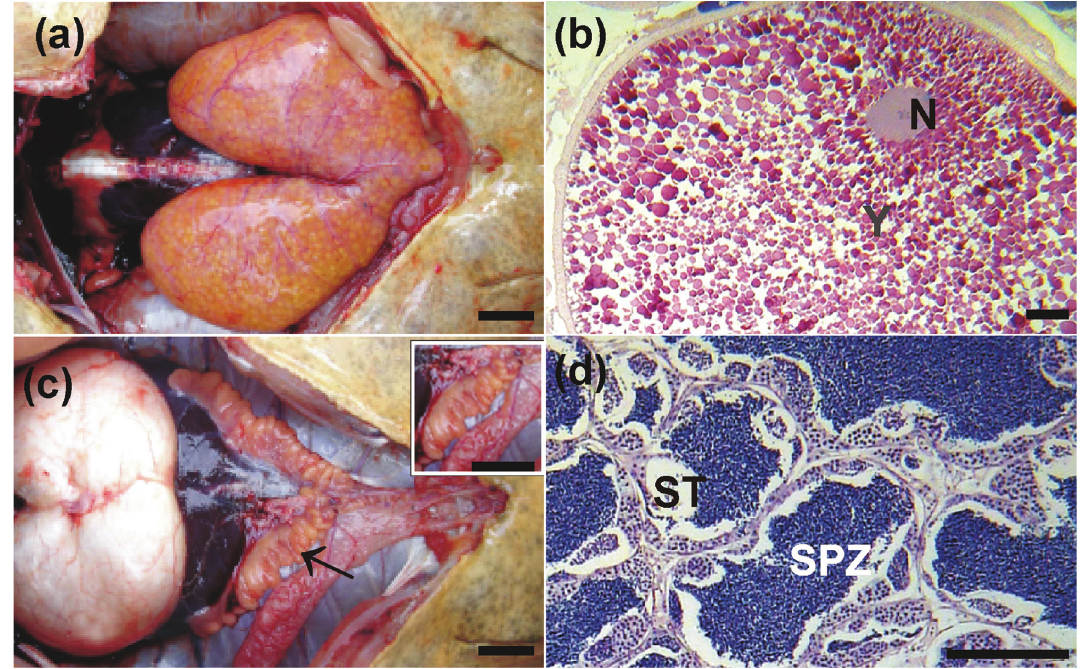
Fig. 2. Macro and microscopic morphology of the ovaries ( a-b ) and testis ( c-d ) mature of the Lophiosilurus alexandri . ( a ) The mature ovaries were bulky, highly vascularized, yellowish and presenting large vitellogenic oocytes. ( b ) Histological section of the vitellogenic oocyte characterized by the presence of acidophilic yolk globules (Y) throughout the ooplasm and nucleus (N) migrating toward the animal pole. ( c ) Mature testis (arrow) are whitish, turgids, vascularized and with well developed fringes (Insert showing fringes). ( d ) Mature testis showing seminiferous tubules (ST) filled by spermatozoa (SPZ). (a, c and insert) bars 1cm; (b and d) stained with hemotoxylin-eosin and bars 100 μ